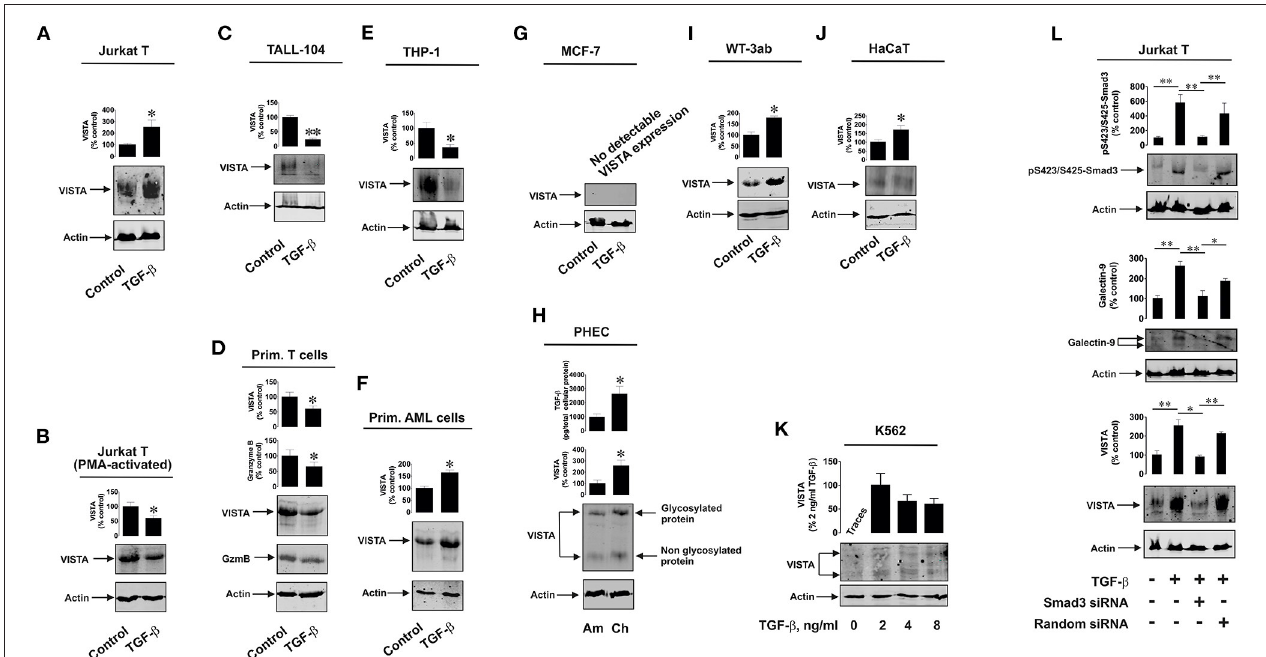
FIGURE 1 | Differential effects of TGF- β on VISTA expression in human T lymphocytes and various rapidly proliferating cell types. Resting Jurkat T cells (A) and those activated for 24h with 100nM PMA (B) , TALL-104 cytotoxic T cells (C) , primary human T lymphocytes (D) , THP-1 human AML cells (E) and primary human AML blasts (F) as well as MCF-7 breast cancer cells, (G) WT-3ab Wilms tumor cells (I) , non-malignant HaCaT keratinocytes (J) were exposed for 24h (primary T cells – for 16h) to 2ng/ml TGF- β followed by Western blot detection of VISTA expression as outlined in Materials and Methods. In primary human T cells (D) , granzyme B